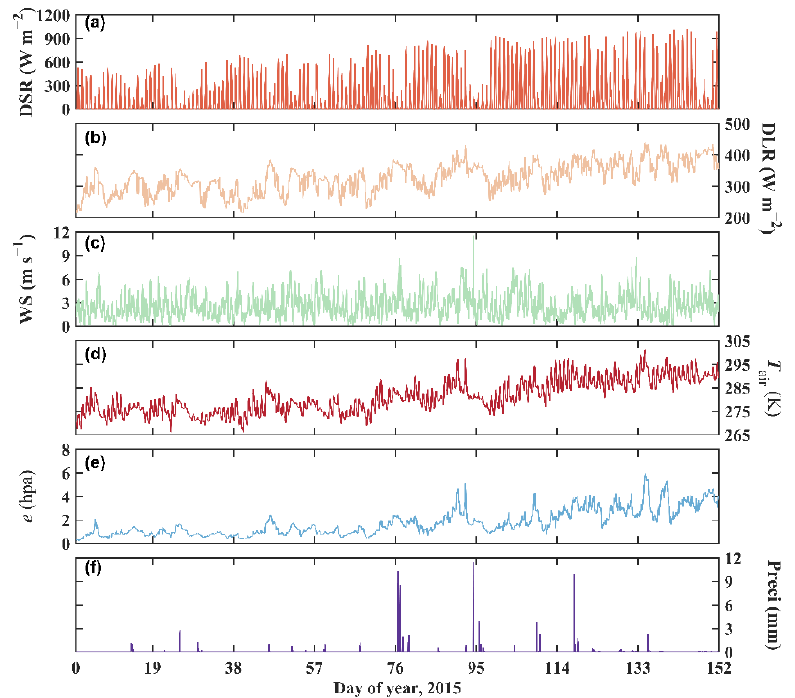
Figure 2. Time series of the 30-min meteorological forcing data collected during the observation period from 1 January to 31 May 2015: ( a ) downward shortwave radiation (DSR); ( b ) downward longwave radiation (DLR); ( c ) wind speed (WS); ( d ) air temperature ( T air ); ( e ) vapor pressure; ( f ) precipitation